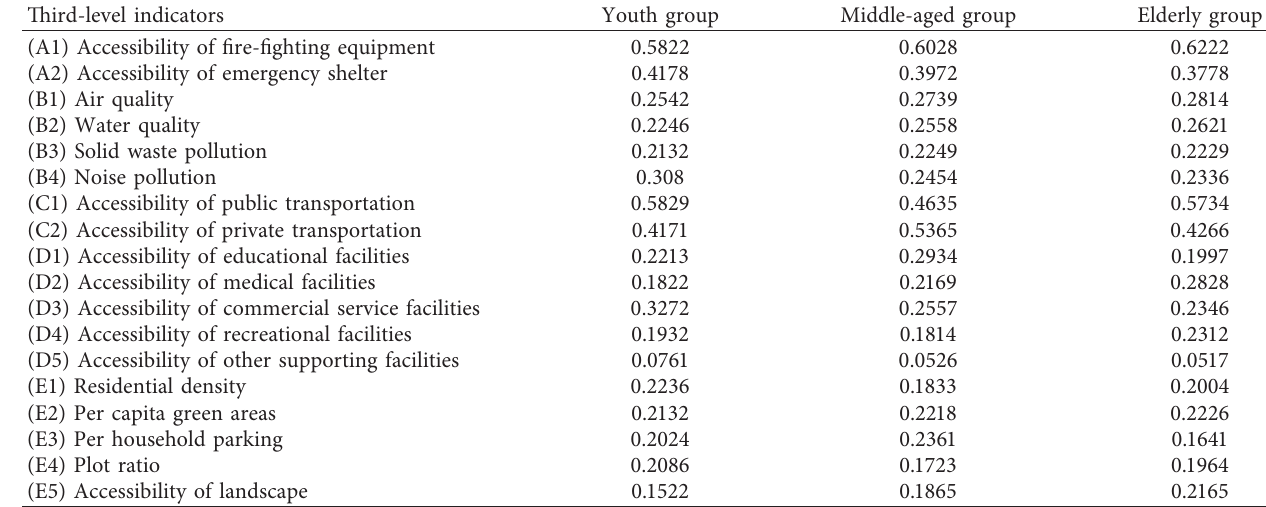
Table 2: The weights of three-level indicators considering the preferences of different age groups.